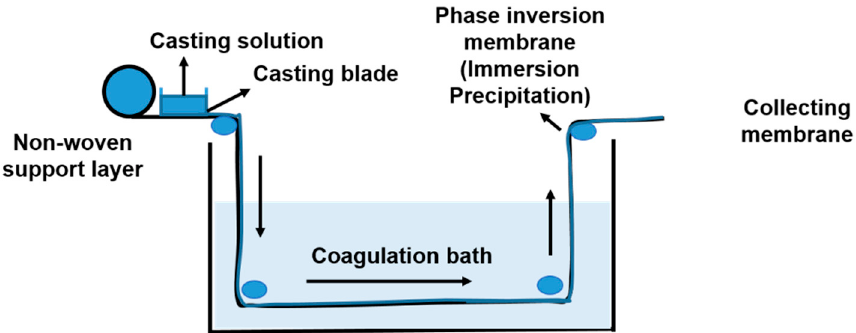
Figure 3. Phase inversion immersion precipitation .